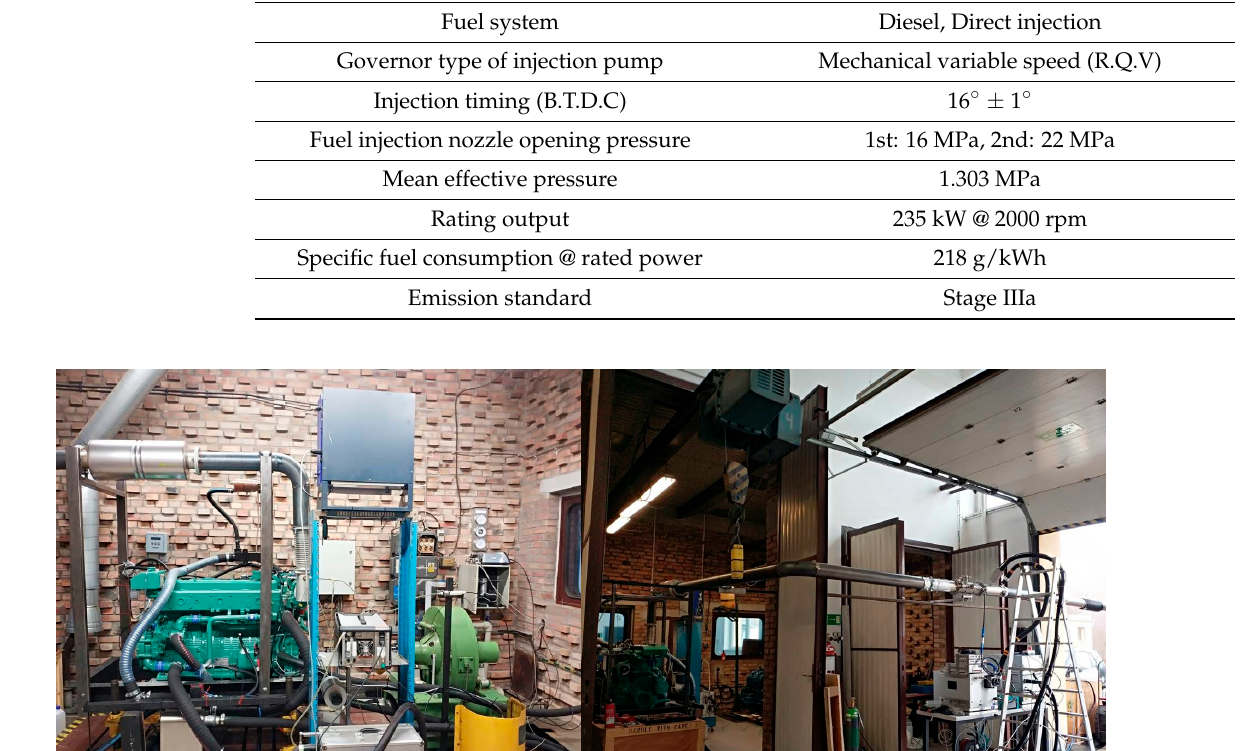
Table 5. Technical specifications of the gas analyzer employed in this study.